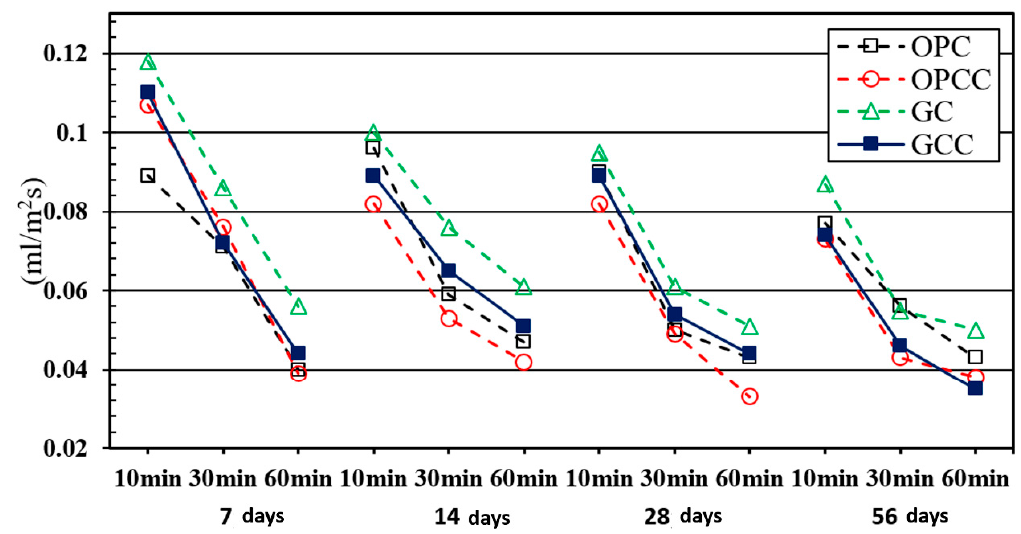
Figure 7. Comparison of the absorption rate of concrete. Table 15. Initial surface absorption of concrete (ml/m 2 s).